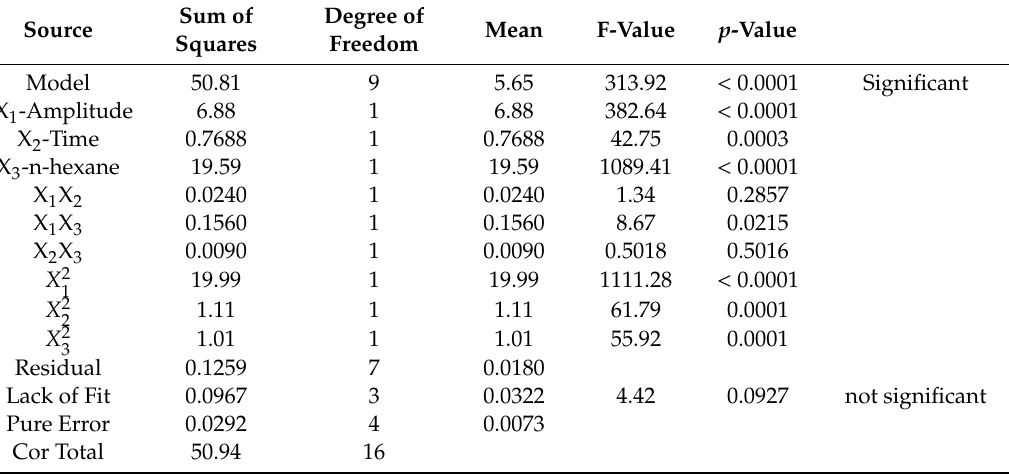
Table 5. Analysis of variance results for a quadratic regression